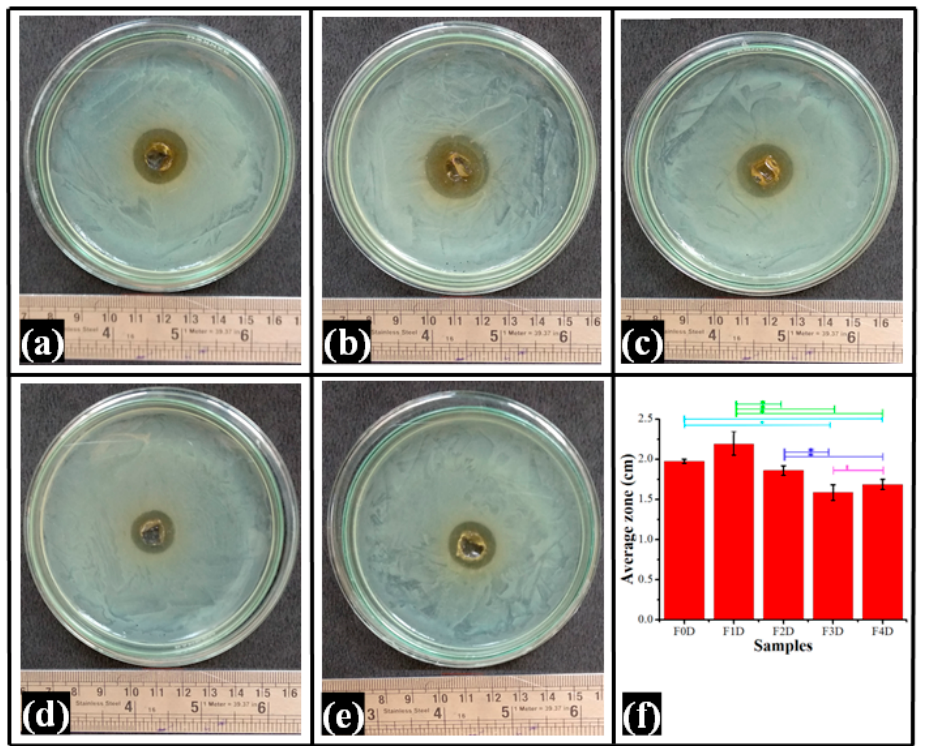
Figure 12. ( a – e ): Pictures displaying the zone of inhibition. ( f ) Quantification of antibacterial activity of CPH-loaded films. The values in the graph are denoted as the mean of the triplicate ± standard deviation. The different values ( p < 0.05) are represented with symbol “*”.